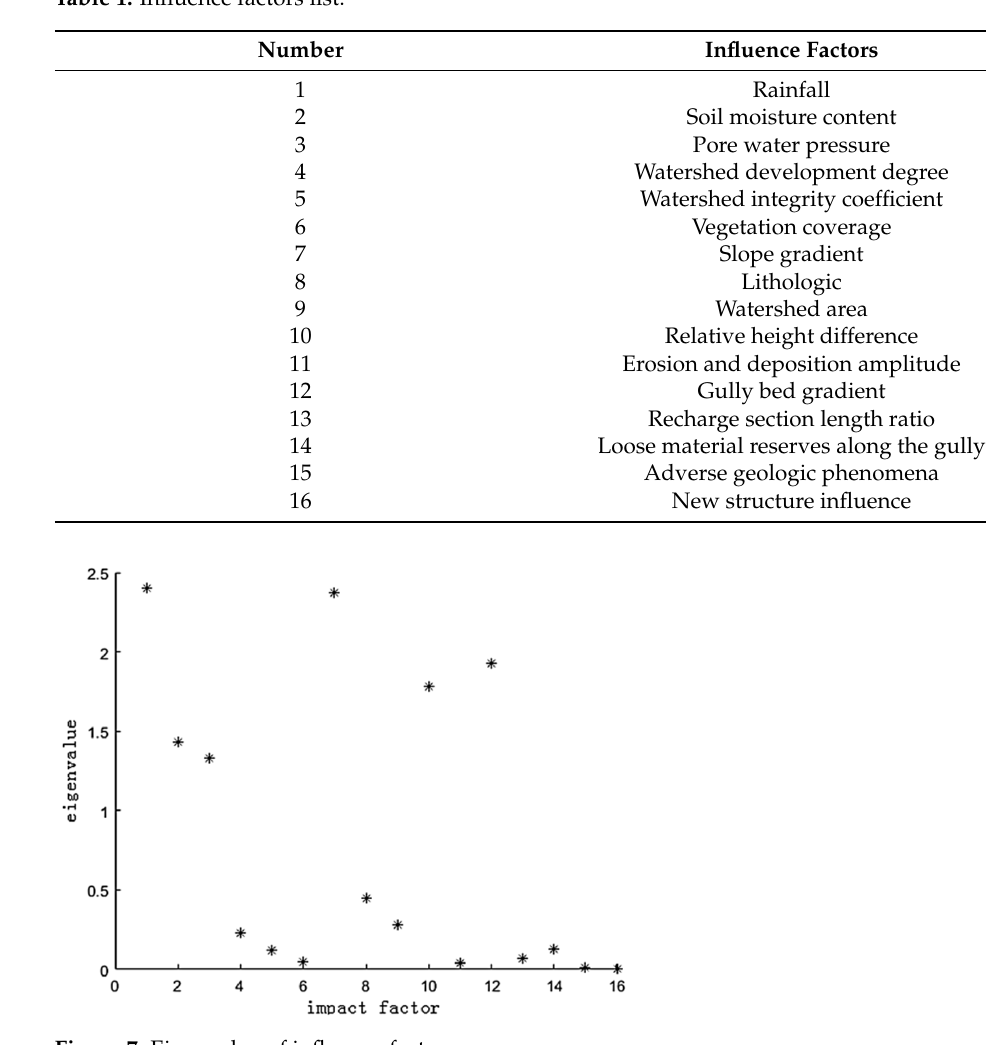
Figure 9. Relationship between influence factor dimensions and forecast accuracy. It is evident from Figure 9 that with the increase in the dimension of debris flow impact factors, the prediction accuracy of the model is gradually improved. When the number of dimensions reaches six, the model’s prediction accuracy is stable. There is no apparent change in the model’s prediction accuracy with the increasing number of im- pact factors. Therefore, the dimension of impact factors is selected as six. According to the FMPCE algorithm mentioned above, the principal components are extracted. The influ- encing factors finally extracted include rainfall, slope gradient, gully bed gradient, rela- tive height difference, soil moisture content and pore water pressure. Through the study